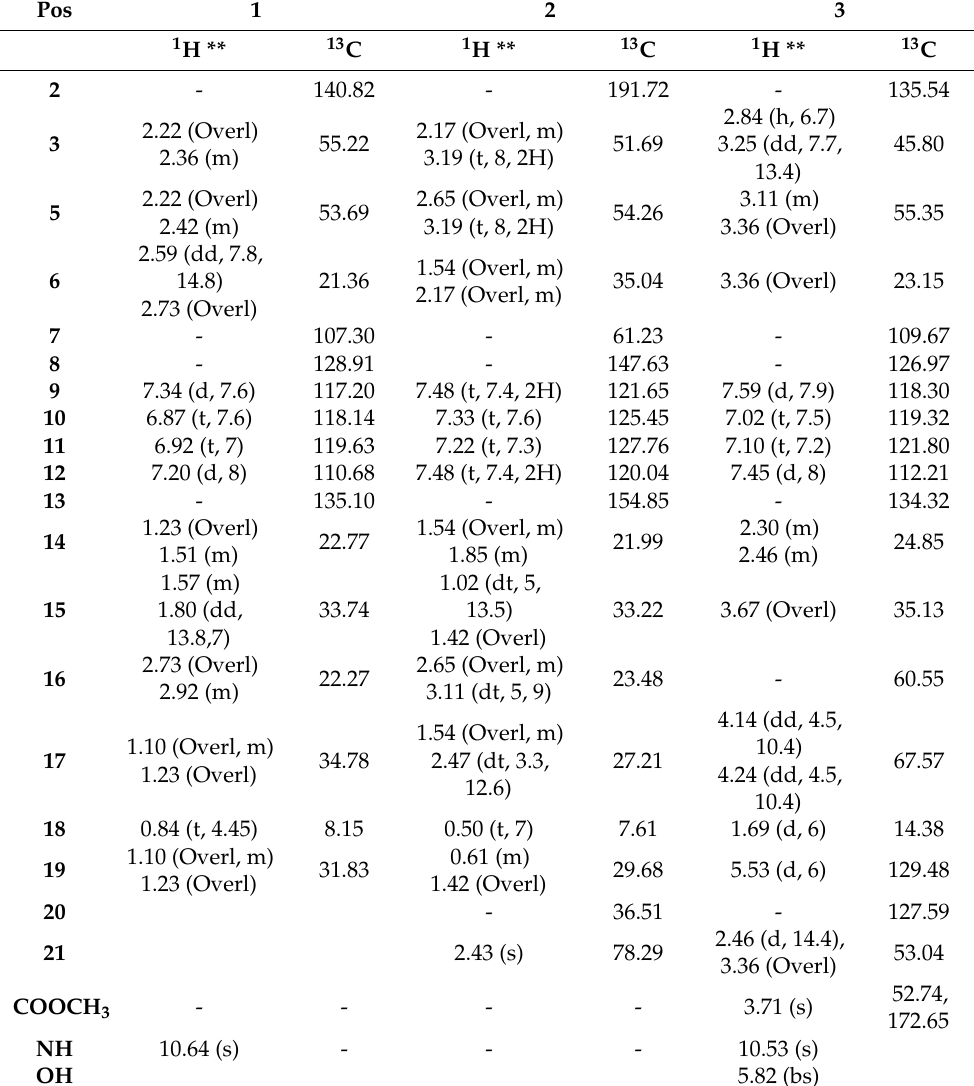
Table 1. 1 H and 13 C-NMR data of compounds 1 , 2 and 3 in CD 3 OD